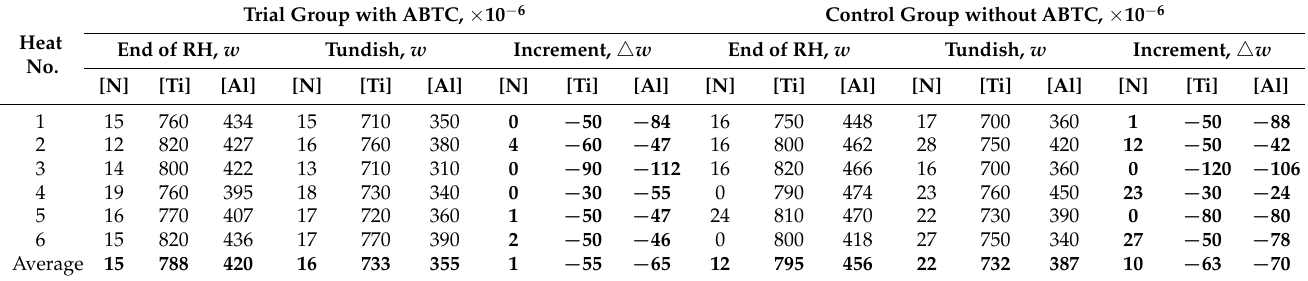
Table 5. Mass fractions of nitrogen, titanium, and aluminum of steel samples at the end of RH and in